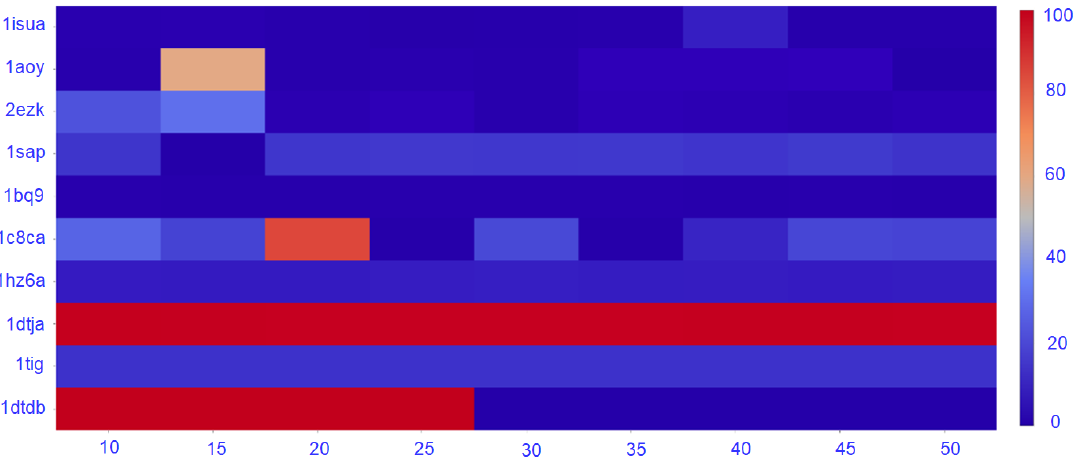
Figure 5. Purity for the range of k from 10 to